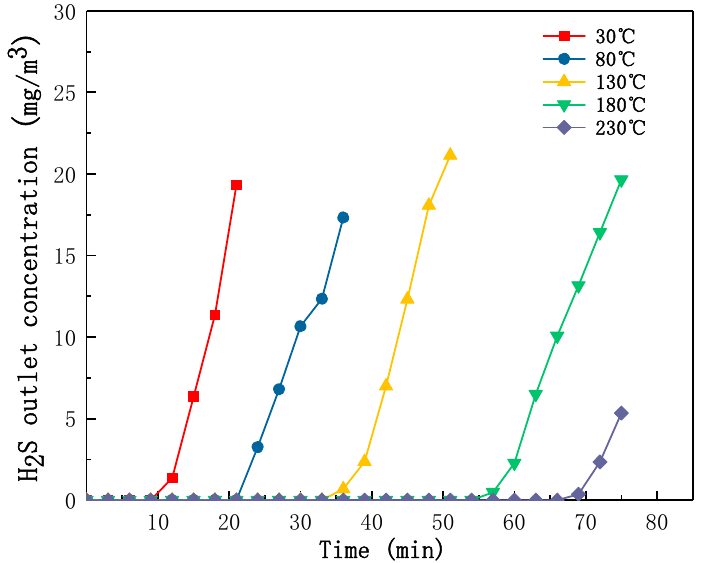
Figure 8. The breakthough curves of hydrochar S5C5 under different adsorption temperatures (auxiliary agent, cationic PAM; cationic PAM concentration, 0.5 g/L). In the adsorption and oxidation process of H 2 S, the change in the oxygen functional groups on the surface of the hydrochar plays an important role. The quinone and carbonyl groups on the surface of the hydrochar can react with molecular H 2 S. The C=O bond and C=C bond were broken and combined with H 2 S to form the S-O bond. This process was endothermic and favored the rising temperature. When the ratio of chitosan to starch is 1:1, the cationic PAM concentration is 0.5 g/L, and the temperature is 230 °C, the maximum sulfur capacity of the hydrochar S5C5 is 28.06 mg/g-adsorbent. 2.3. Adsorption Mechanism The adsorption of H 2 S on the hydrochar consisted of three parts: the first part is the reaction of H 2 S with the metal active sites, such as CuO and ZnO [34]; the second part is the reaction of H 2 S with the oxygen-containing functional groups and carbon on the sur- face of the hydrochar to form C-S bonds and O-S bonds; the third part is the physical adsorption process of H 2 S on the surface of the hydrochar [33]. To further investigate the reaction mechanism, the chemical valence states of the el- ement in the whole process were analyzed by XPS. The XPS spectra of S, Cu, and Zn are shown in Figures 9–11.